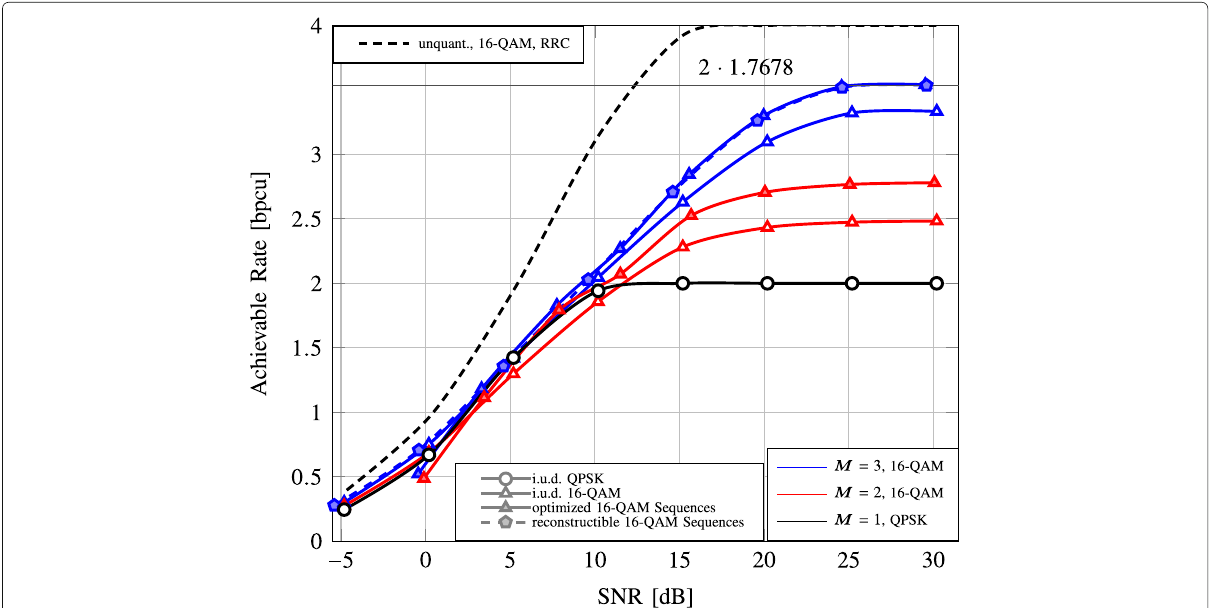
Fig. 9 Achievable rate with 1-bit quantization and M -fold oversampling, QAM modulation, and various sequence designs, N =